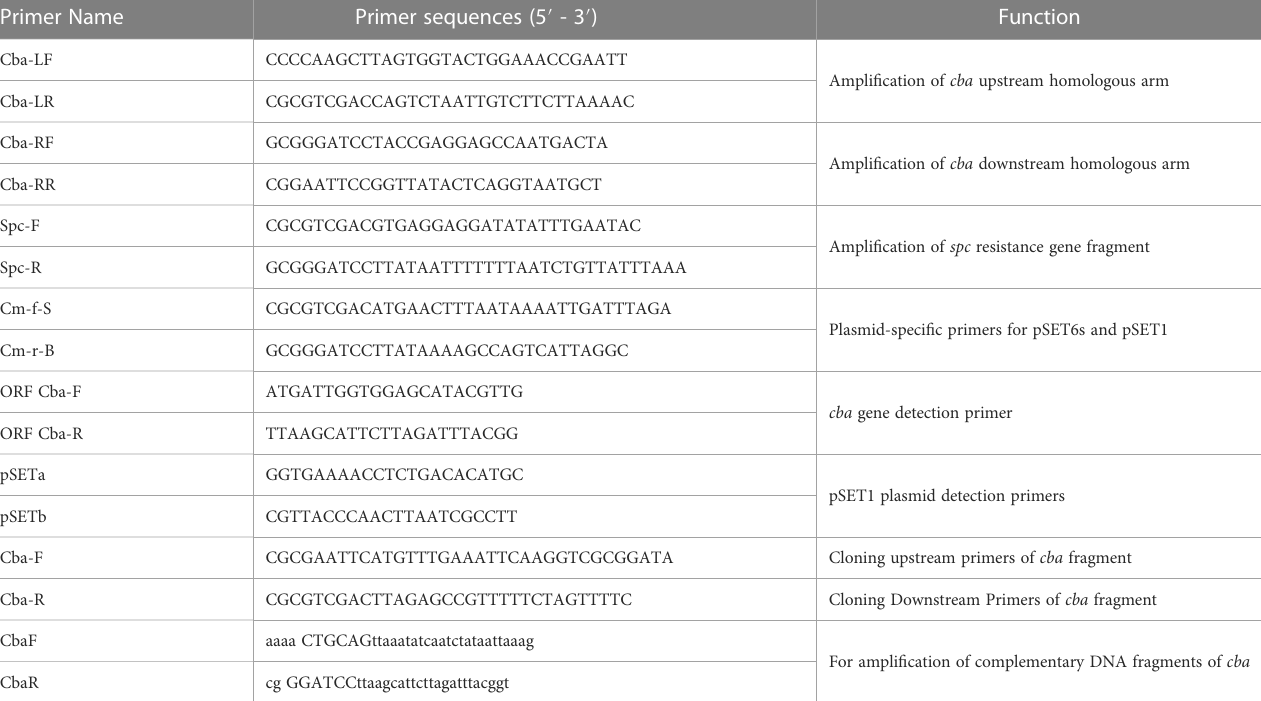
TABLE 2 Related primers of cba mutation